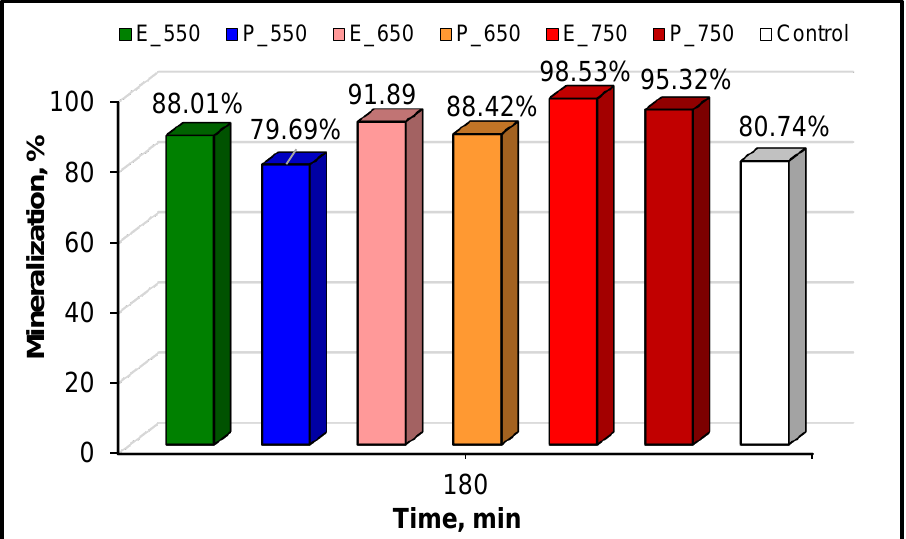
Figure 9. Mineralization degree of the as-prepared TiO 2 samples calcined at different temperatures and the control after 180 min of UV-A irradiation. CA = 10 mgL −1 , catalyst = 0.5 gL −1 and natural pH.